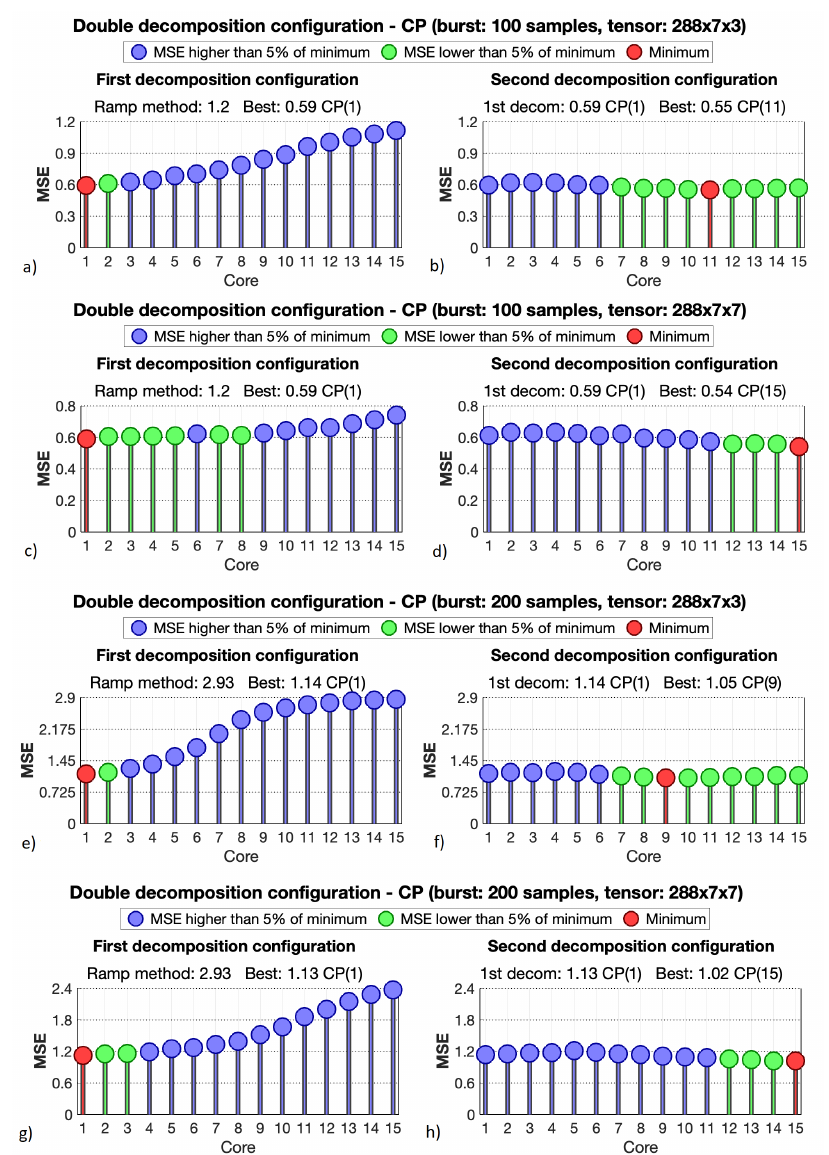
Figure 8. Test of double decomposition configuration for the CP model. Each pair of graphics show the result for different conditions of burst length and size of the tensor. ( a , c , e , g ) show the MSE obtained applying only the first decomposition procedure until the bloc number five of the whole algorithm, for different core configurations. ( b , d , f , h ) show the MSE of the double decomposition method , the complete algorithm, for different core configurations on the second decomposition, and using the best core configuration obtained for the first decomposition which is